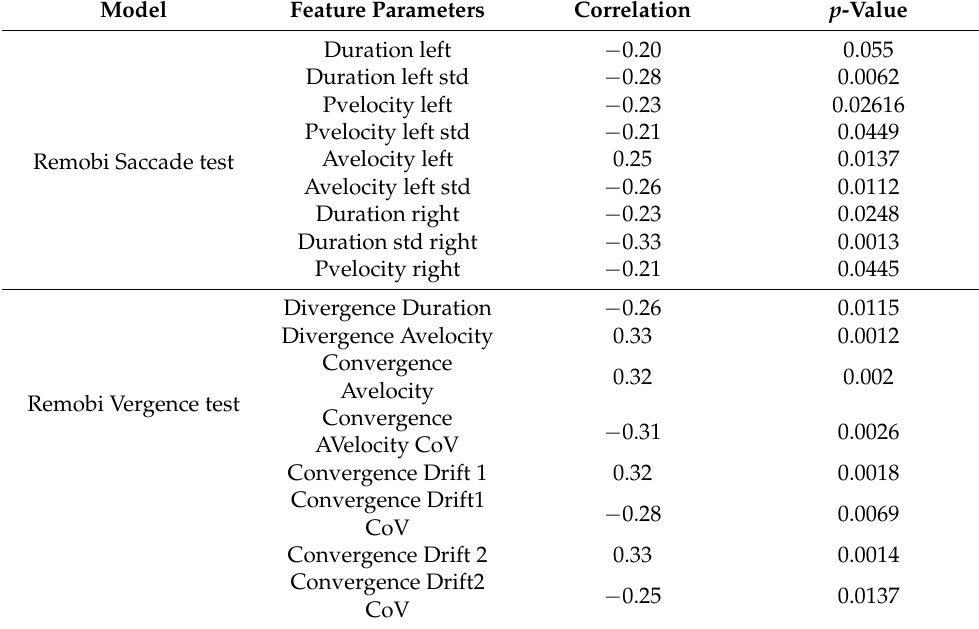
Table 6. The eye movement parameters selected for the Remobi saccade and vergence datasets.